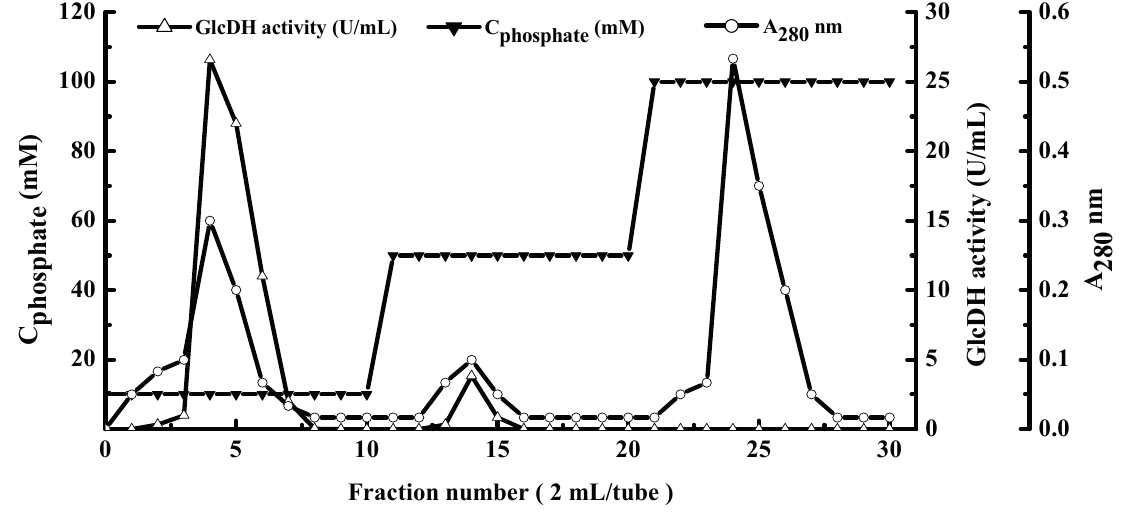
Figure 1. Elution profiles of GlcDH from A. globiformis C224 by hydroxylapatite column